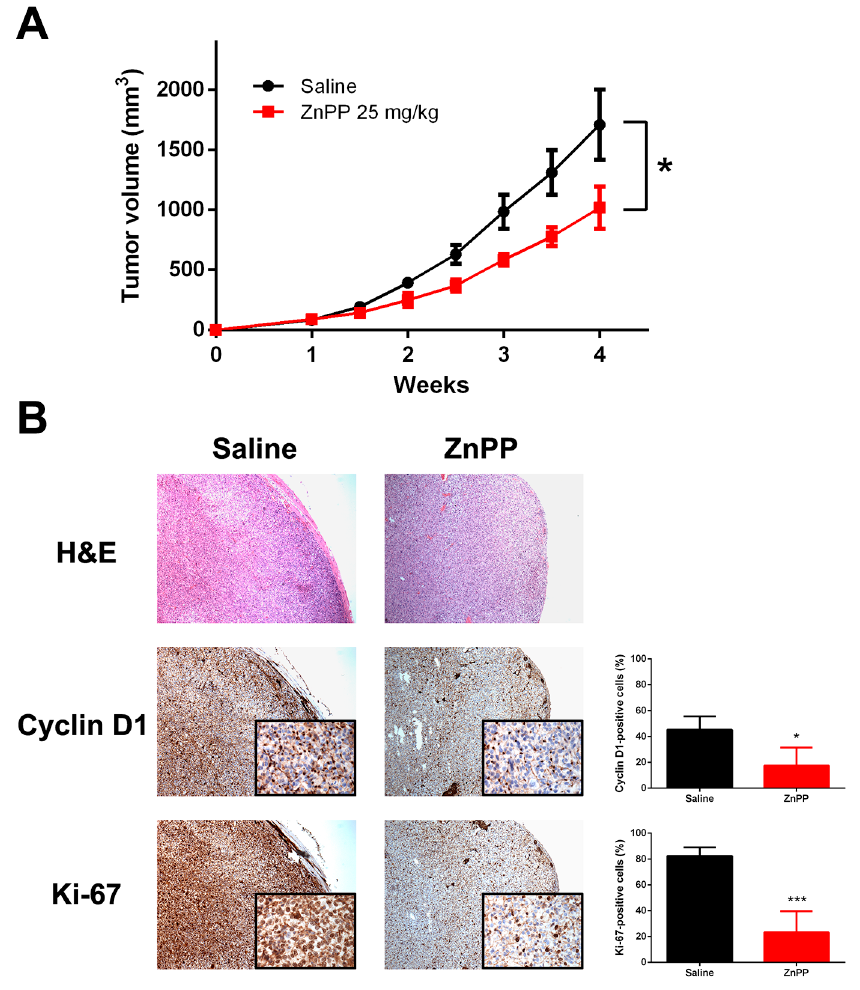
Figure 6. Xenograft tumor growth suppressed by the administration of a heme oxygenase-1 inhibitor. Nude mice were allocated to receive i.p. zinc protoporphyrin-IX (ZnPP) or saline control ( n = 6 per group) following subcutaneous implantation of FTC-133 thyroid cancer cells, and the xenograft tumor volume was measured periodically ( A ). * p < 0.05 versus control. Representative microphotographs of tumor sections stained for H&E, cyclin D1, and Ki-67 are shown ( B ). Stained cells were manually counted from four separate areas on the slide and averaged per group. Original magnification ×40; inset, ×400. * p < 0.05 versus control, *** p < 0.001.